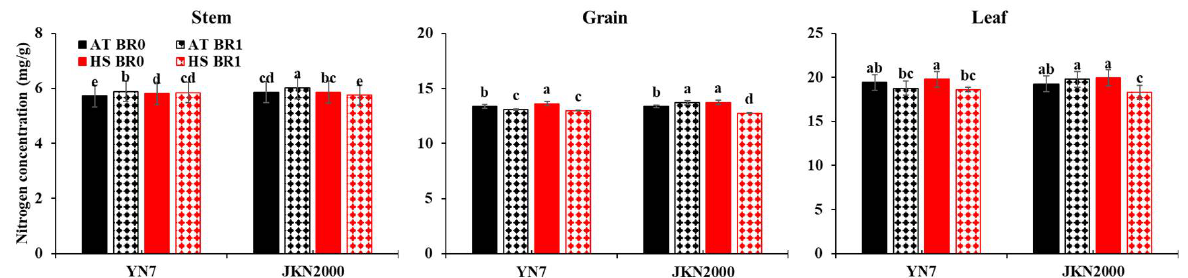
Figure 4. Effects of foliar BR application at the silking stage on nitrogen contents in leaf, stem, and grain of fresh waxy maize under post-silking ambient and high temperatures. AT, ambient temperature; HS, heat stress; BR0, application of water; BR1, application of 0.25 mg/L BR. The different letters on the column mean the difference was significant at the p < 0.05 level.